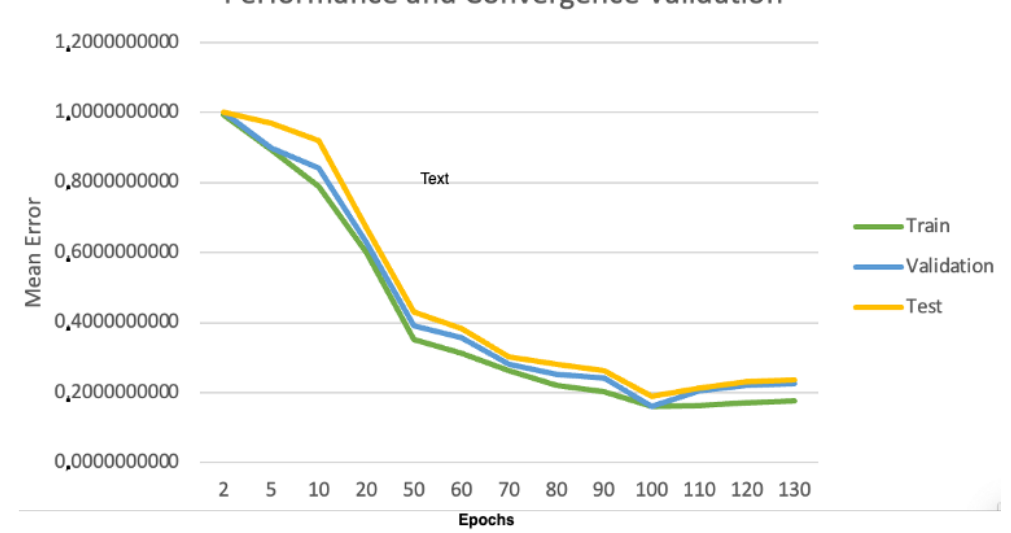
Figure 14. Multi-layer feed-forward neural network (MLN) with back propagation neural conver- gence graph (Ox = Epochs, Oy = Mean Error).